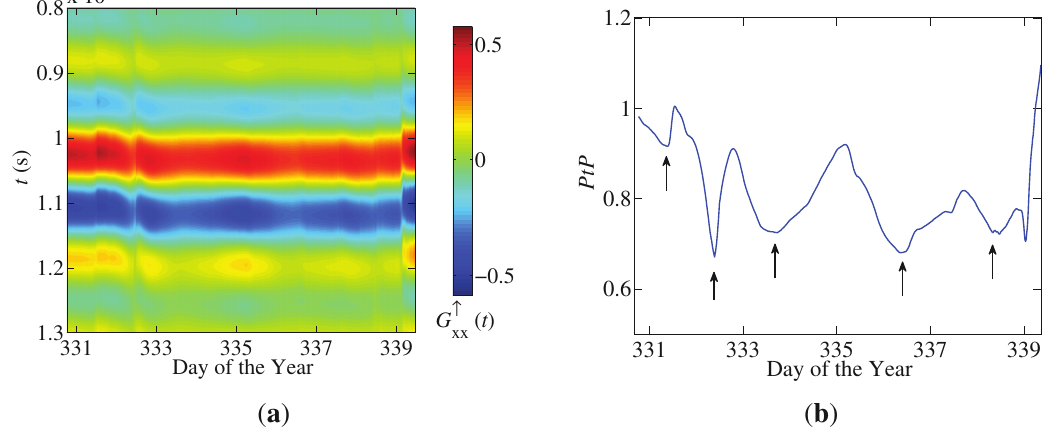
Figure 5. ( a ) Radar signal in the time domain for a single measurement and ( b ) peak-to-peak ( P tP ) maximum amplitude of the time-lapse GPR data, with the effect of the five freezing and thawing events clearly observed as marked by